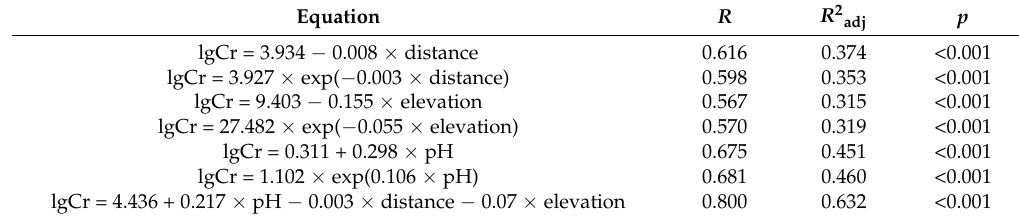
Chromium concentration in soil was lg-transformed to ensure homogeneity of